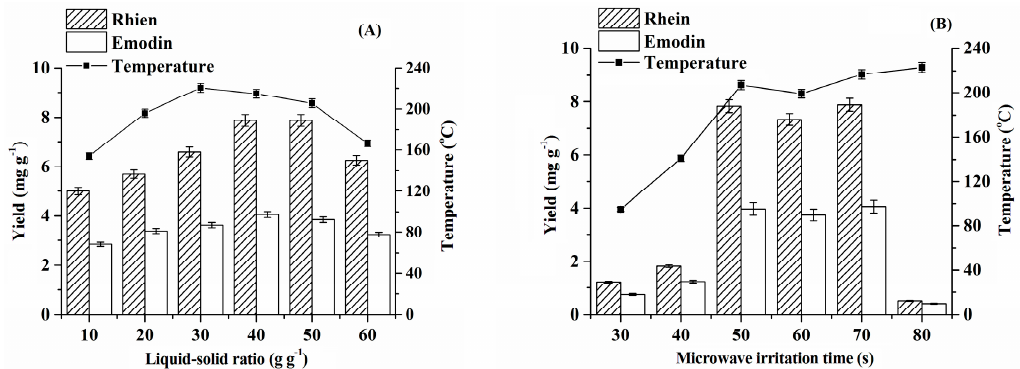
Figure 2. Influence of liquid–solid ratio ( A ) (microwave irradiation power, 280 W; microwave irradiation time, 70 s; C IL = 80%) and microwave irradiation time ( B ) (microwave irradiation power, 280 W; liquid–solid ratio, 40 g·g − 1 ; C IL = 80%) on the extraction efficiency.